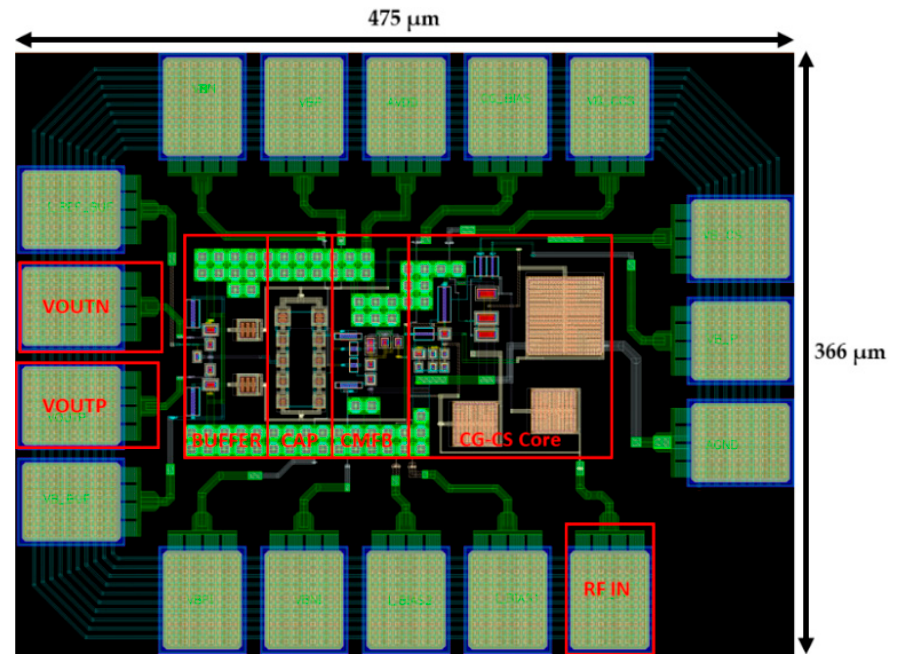
Figure 4. Layout of balun-LNA including core, feedback, and buffer. Table 1. Device dimension and bias point.